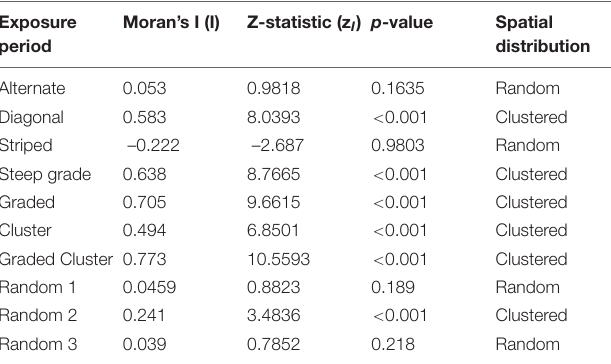
TABLE 1 | Moran’s I analysis results by exposure period for the patterns and random data sets, including Moran’s I value (I), the z-statistic (z I ), and the associated p